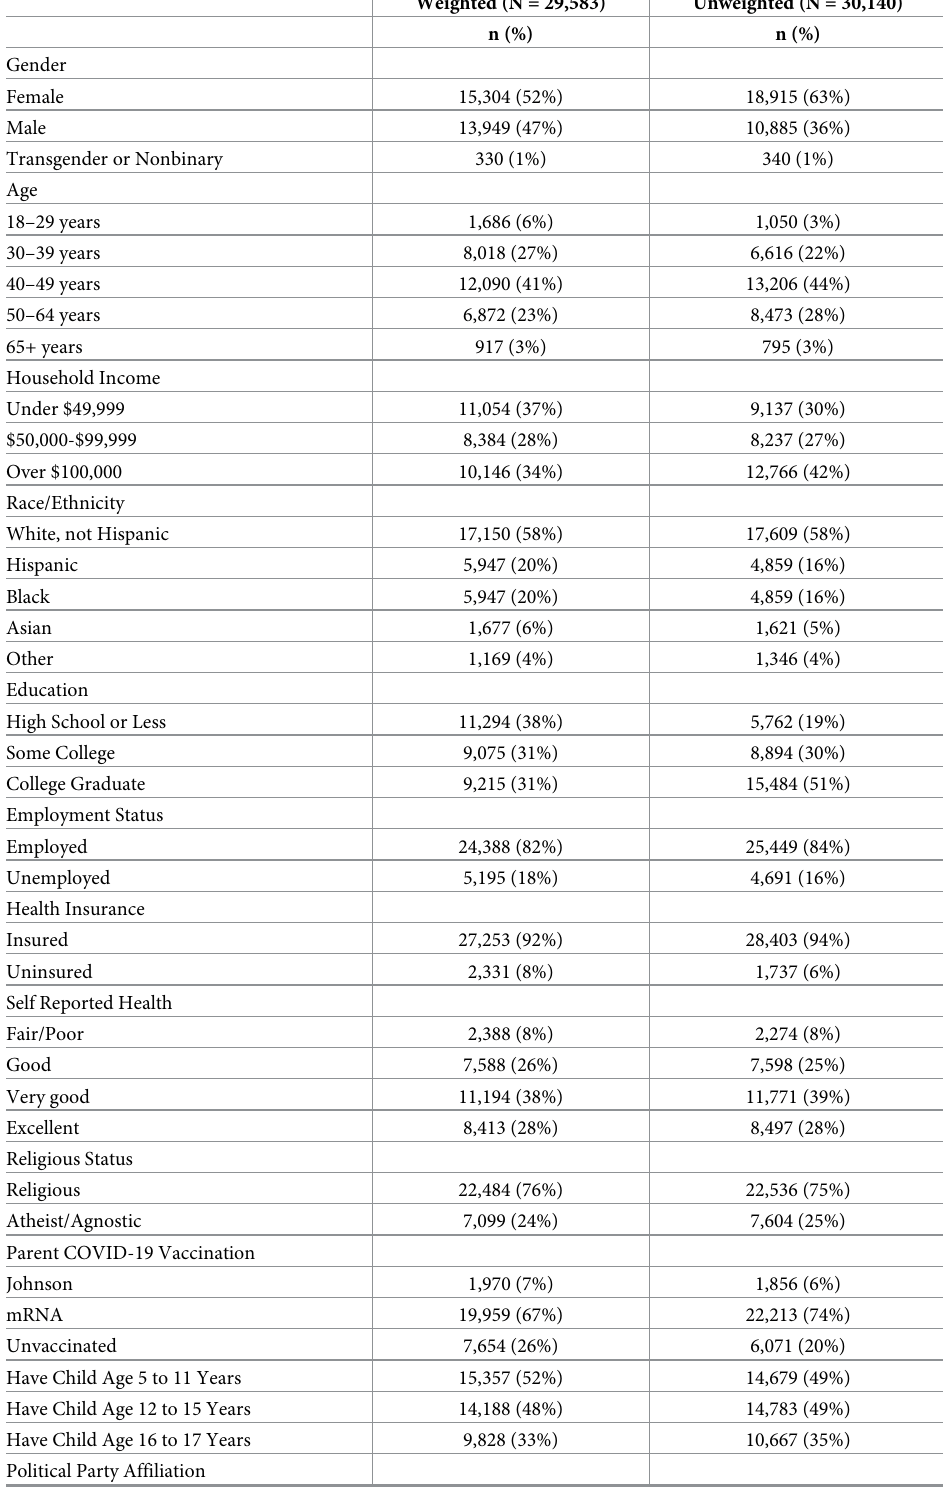
Table 1. Characteristics of studied